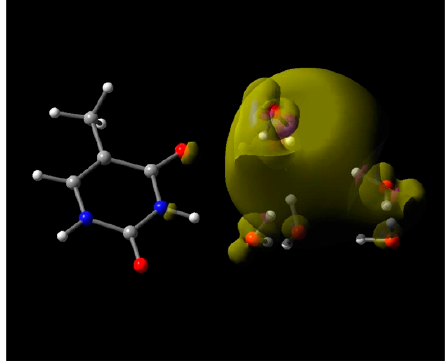
Figure 3. Total spin density plot of thymine (T)–6H 2 O • − . The structure is optimized to a local minimum using the B3LYP-PCM/6-31++G** method. Reprinted with permission from reference [72]. Copyright, 2016, American Chemical Society.